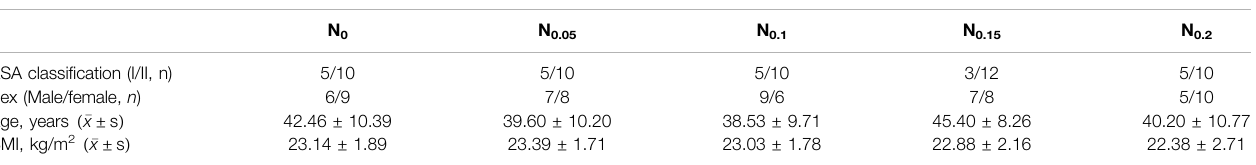
TABLE 1 | Patient demographic characteristics.